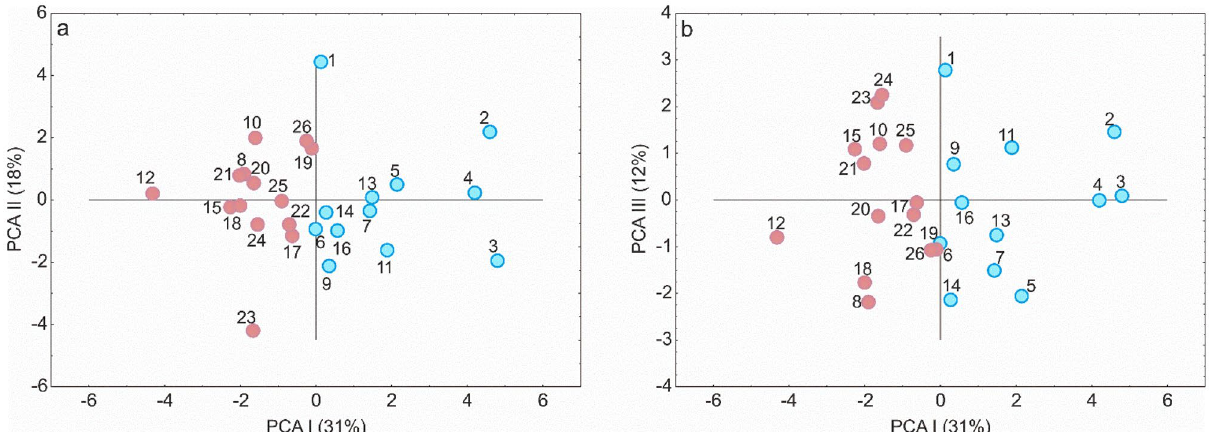
Figure 4. Distribution of the Carex buekii populations studied in two-dimensional space (Principal Component Analysis, PCA). Blue and pink circles represent group I and group II populations, respectively (cf. Fig. 3). The populations are numbered as in Table S1. Loadings for the first axis (PC1) (only absolute values ≥ 0.5): CH (culm height) = − 0.82; CLL (cauline leaf length) = −0.73; CLW (cauline leaf width) = −0.72; IL (inflorescence length) = −0.83; MSL (male spike length) = −0.61; BL (bract length) = − 0.85; and GL (glume length) = −0.51. Loadings for the second axis (PC2) (only absolute values ≥ 0.5): FSW (female spike width) = −0.80; UL (utricle length) = −0.75; UBL (utricle beak length) = −0.69; and GL (glume length) = −0.59. Loadings for the third axis (PC3) (only absolute values ≥ 0.5): FSL (female spike length) = 0.51; PL (peduncle length) = 0.50; and UBL/UL (beak length to utricle length ratio) = 0.70.